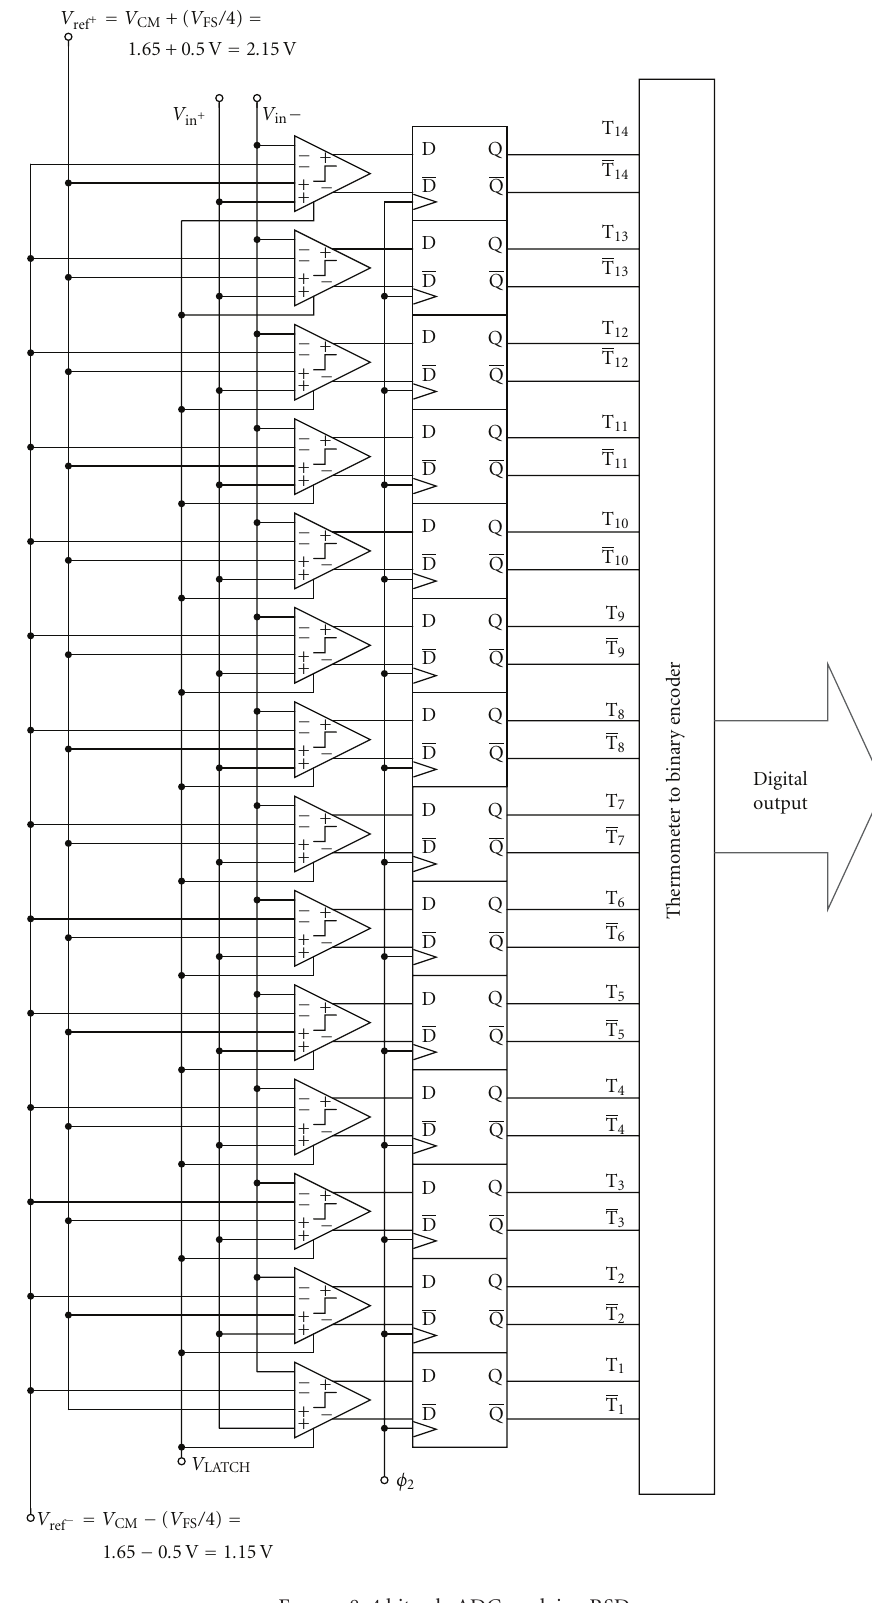
Figure 8: 4 bit sub-ADC applying